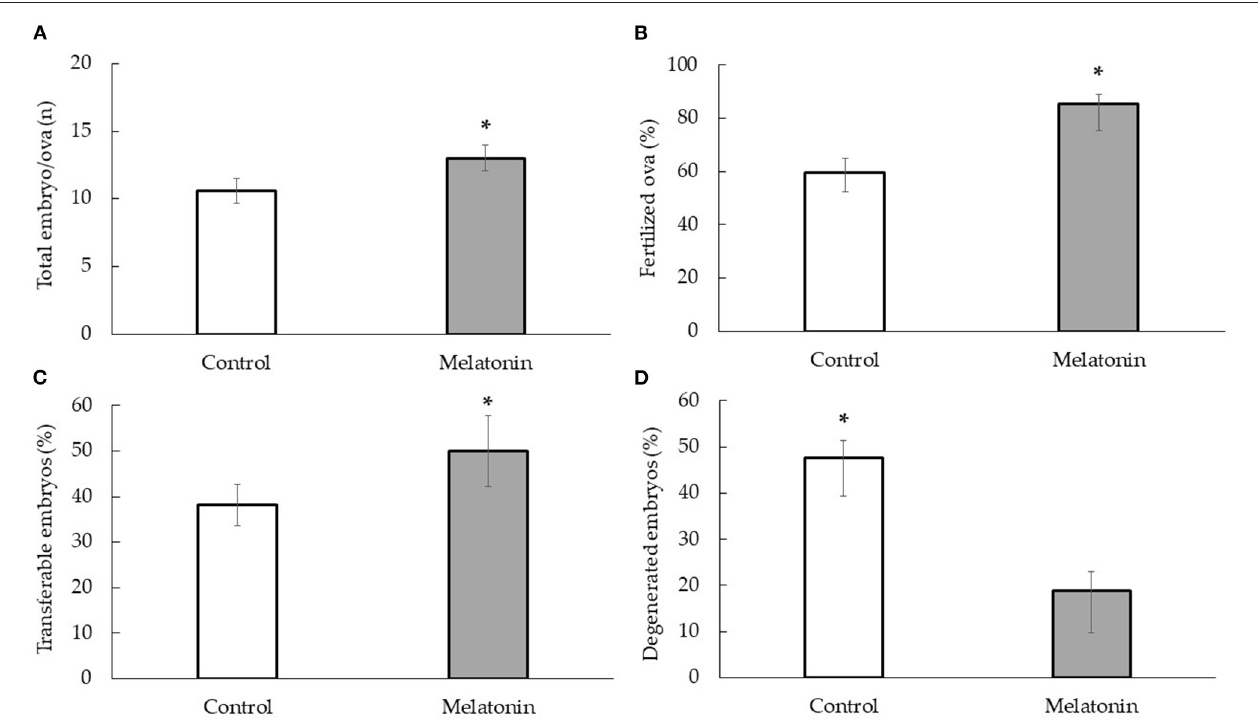
FIGURE 2 | Effect of melatonin treatment with the embryo/ova collection under heat stress condition; total embryo/ova (n) (A) fertilized ova (%) (B) transferable embryos (%) (C) and degenerated embryos (%) (D) in Thai-Holstein crossbred cows; * is significant value within treatment ( p < 0.01).